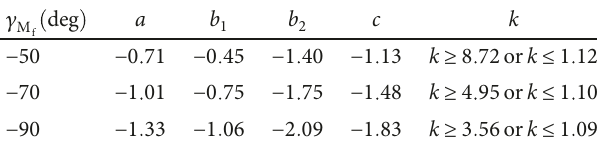
Table 2: Values of N